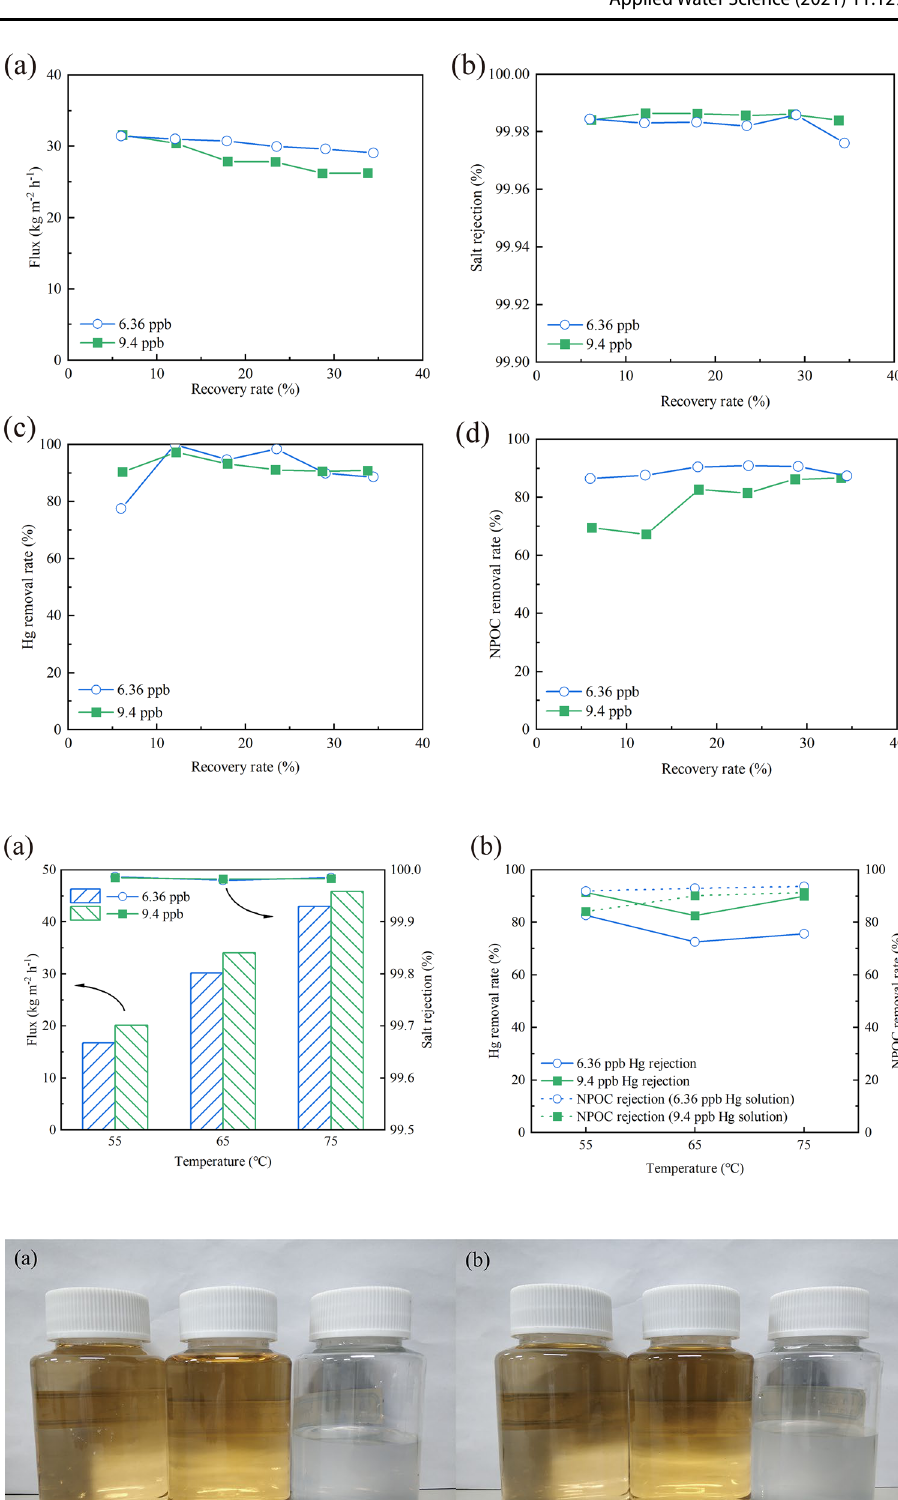
Fig. 5 Pervaporation perfor- mance of c-GO-PEI: a Flux, b Salt rejection, c Hg rejection, d NPOC removal rate(Operating temperature: 65 °C)